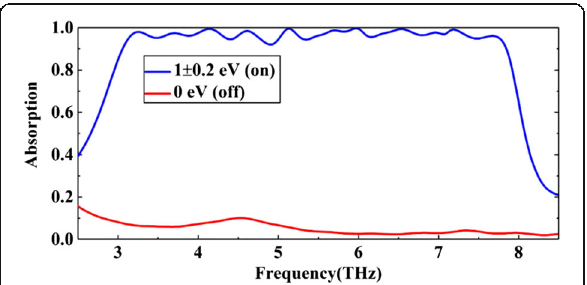
Fig. 2 The calculated absorption spectra of the proposed absorber, where the blue line represents the absorption with high voltage and the red line indicates the absorption with no voltage